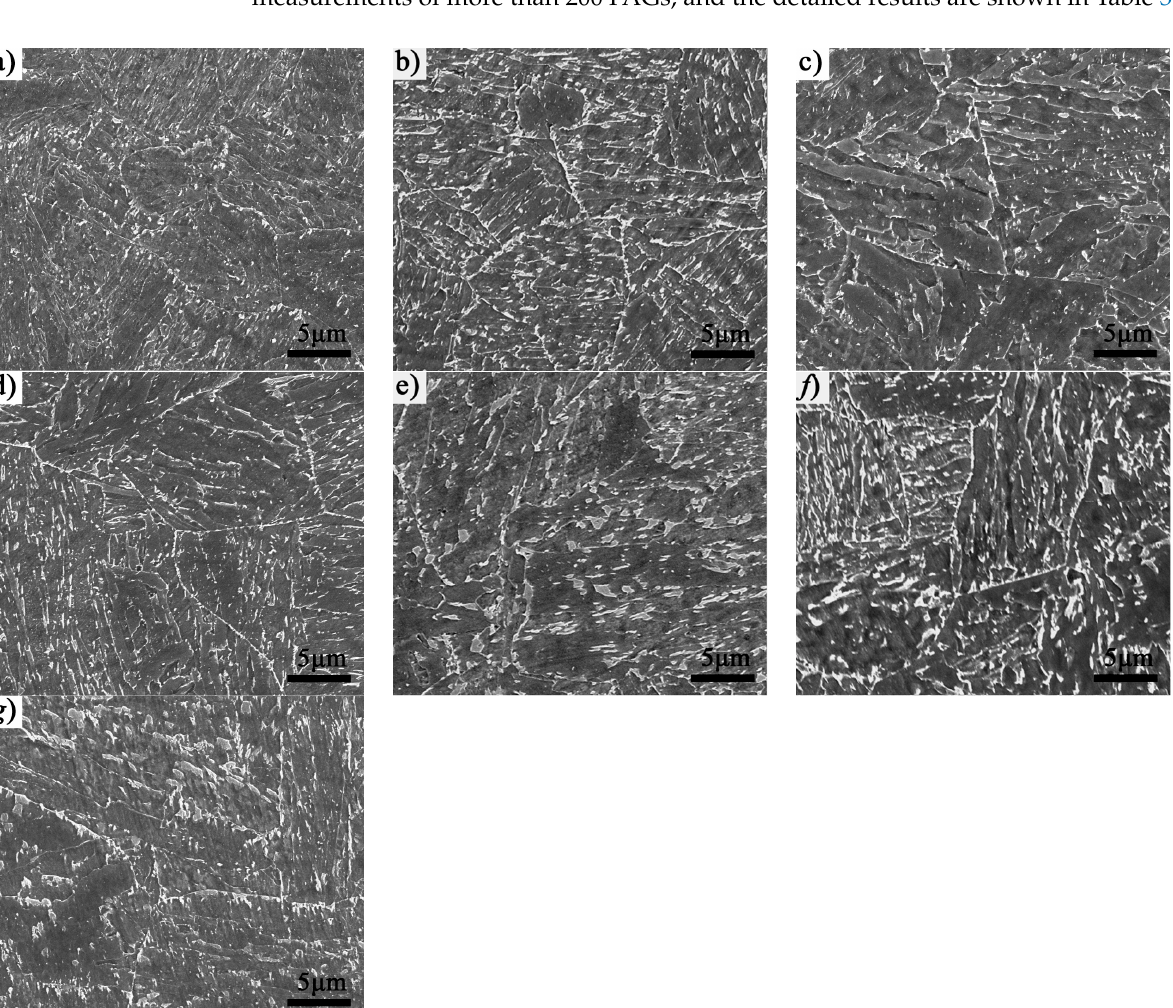
Figure 1. SEM graphs of the specimen at different positions: ( a ) 10 mm, ( b ) 20 mm, ( c ) 30 mm, ( d ) 35 mm, ( e ) 40 mm, ( f ) 50 mm and ( g ) 60 mm, which present a microstructural transition from M to LB and GB.